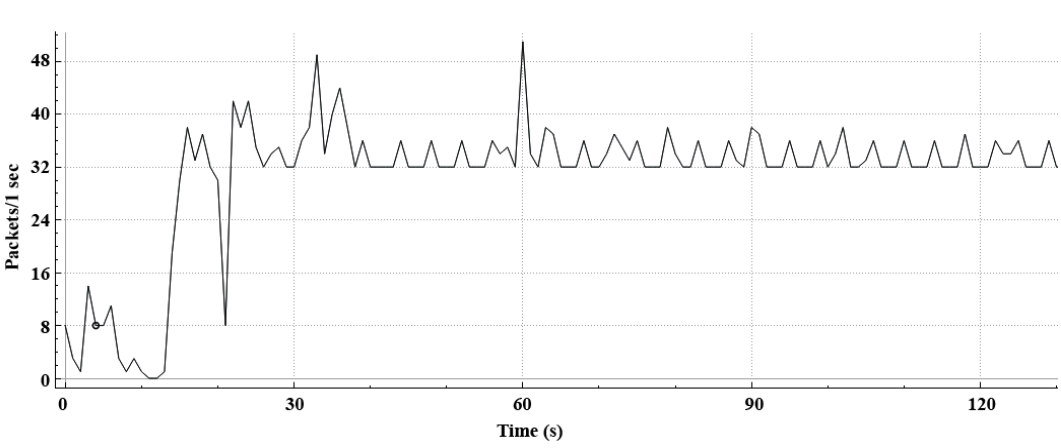
Figure 11. The graph includes the network traffic generated between two devices (M-DUINO and Arduino ONE) and the OPC UA sever connected at the same